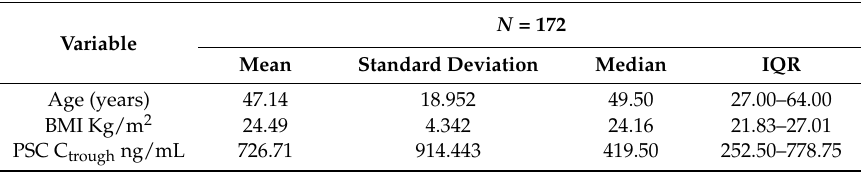
Table 1. Mean, standard deviation, median and interquartile range for age, body mass index and posaconazole plasma